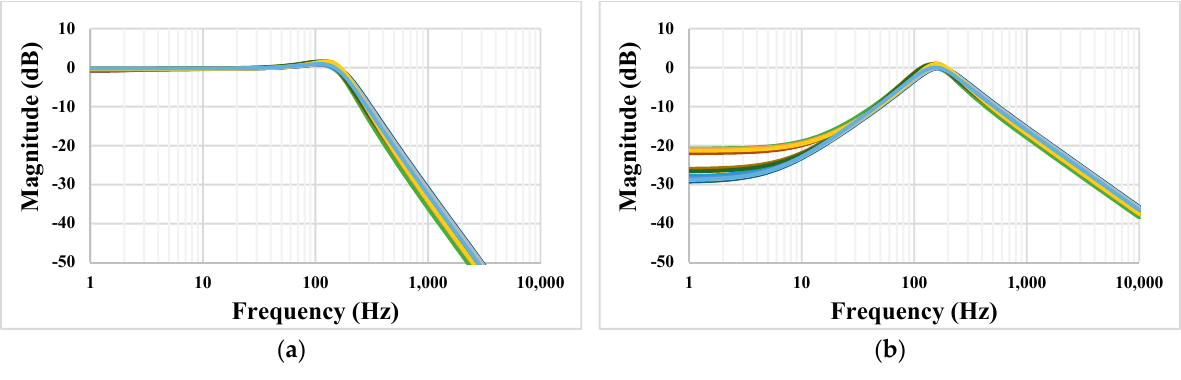
Figure 12. The PVT simulation of the LPF ( a ) and BPF ( b ). Figure 13 shows the transient response of the LPF with an applied input signal of 100mV pp @ 50Hz and its output spectrum. The total harmonic distortion (THD) of 0.33% was achieved, which was kept still below 1% for the input signal of 200 mV pp @ 50 Hz. The output integrated noise of the LPF was 220 µV rms which resulted in a 50 dB dynamic range (DR = 20 × log (V rms-max /V rms-onoise )) of the filter with 1% THD.